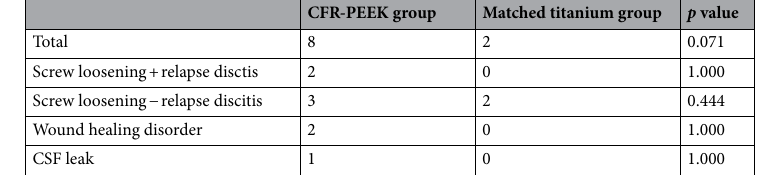
Table 7. Reasons for reoperation of CFR-PEEK group and matched titanium group. Number of revision surgery performed in both groups and the reasons for reoperation. Fisher’s exact test was applied. CSF = cerebral spine